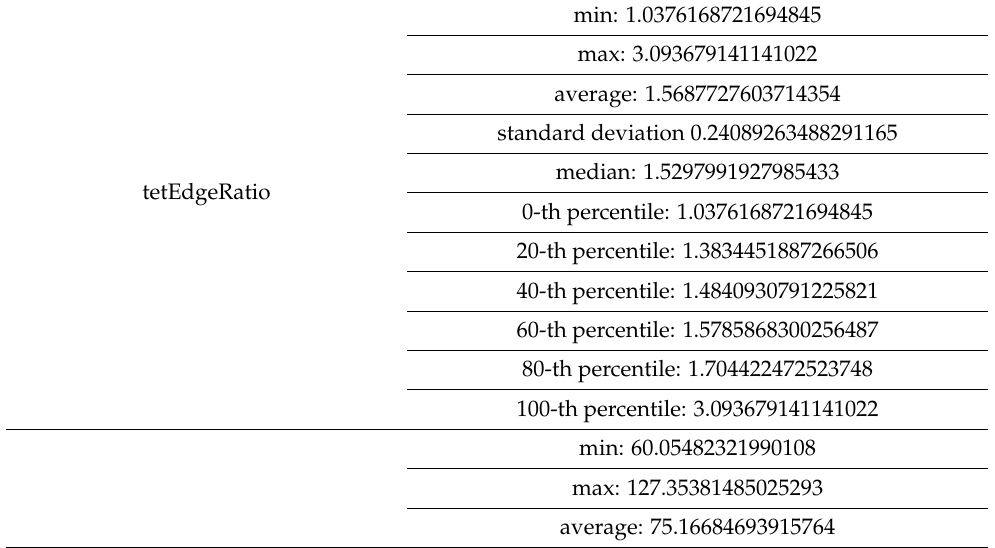
Table 3. Metrics statistics for mesh